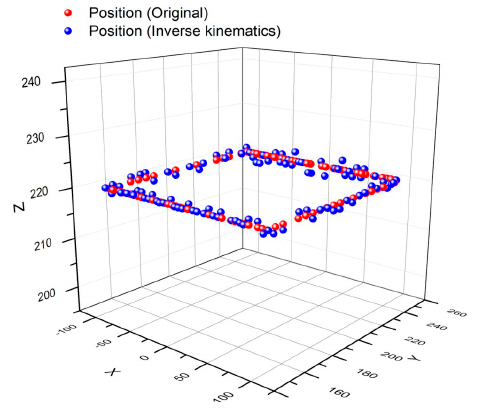
Figure 8. Theoretical and measured paths for a robot arm moving along a rectangular path with a payload.